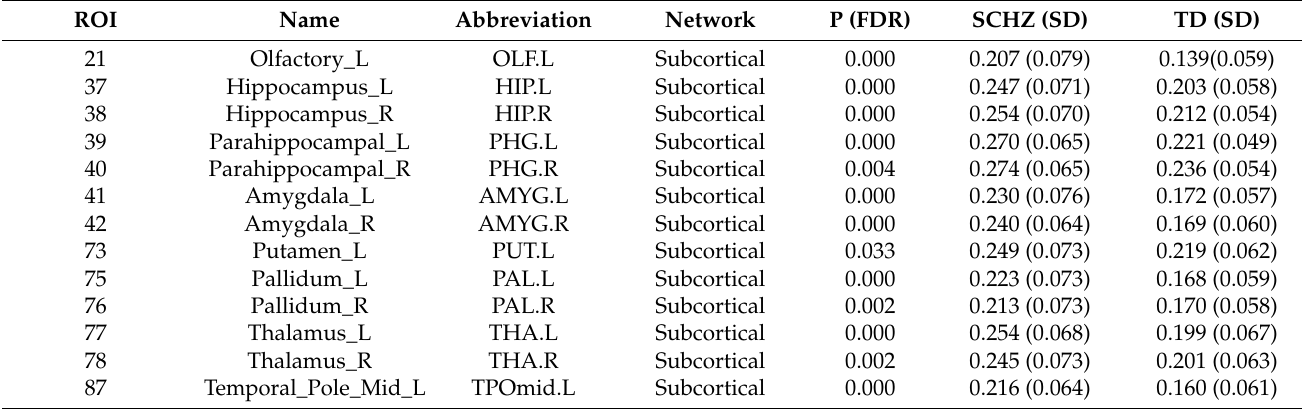
Table 3. Brain regions showing significant differences in the multilayer clustering